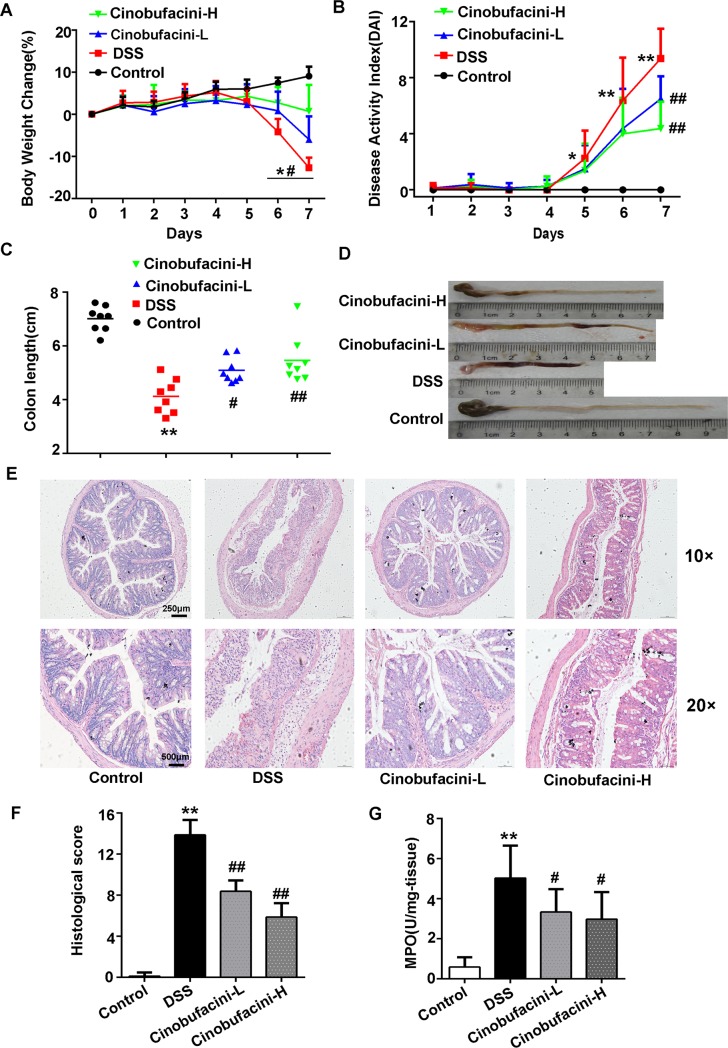
The effect of cinobufacini on DSS-induced colitis in mice.(A) Percent change in body weight. (B) Disease activity index score. (C, D) The change of colon length. (E, F) Representative H&E-stained rectal colonic section and histological score. (G) The myeloperoxidase activity of colonic tissue. Cinobufacini-L means low dose of cinobufacini treatment, which is 10.0 mg/kg body weight; cinobufacini-H indicates high dose of cinobufacini, 30.0 mg/kg body weight. Data shown are the means ± SD. *p < 0.05, **p < 0.01 vs the control group; #p < 0.05, ##p < 0.01 vs the DSS group. n = 8 mice per group.